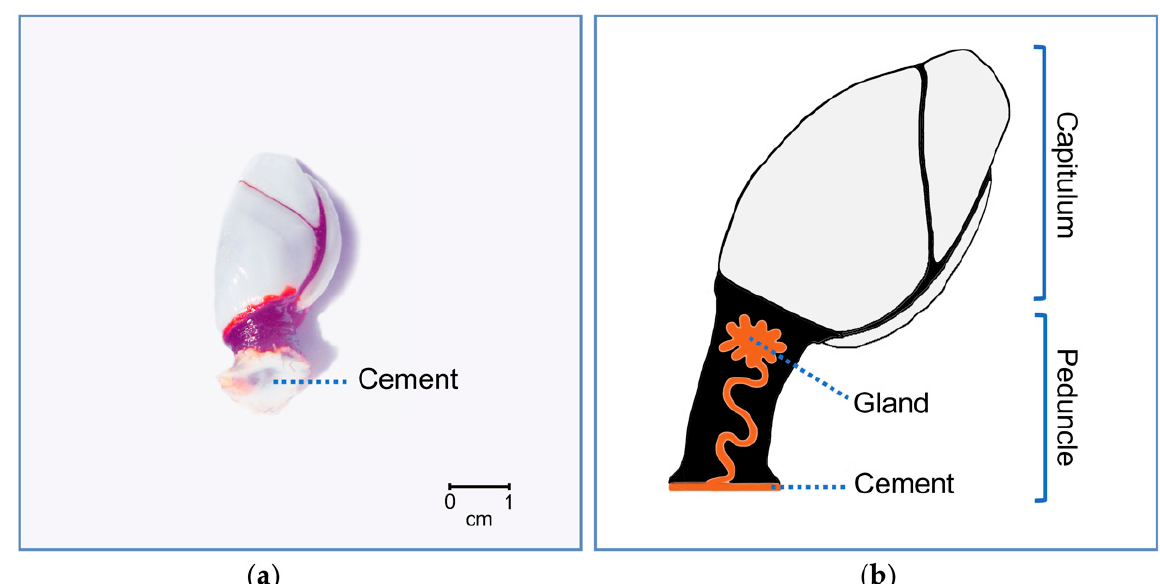
Figure 1. The pelagic gooseneck barnacle Lepas anatifera ( a ) detached from the substrate, showing the cement at the base of the peduncle; ( b ) schematic drawing showing a section of the peduncle, highlighting the cement apparatus, formed by clusters of adhesive-secreting cells that together constitute the gland, located in the upper central core, embedded in an apical layer of connective tissue, just beneath the capitulum. Gland secretion passes through a network of ducts that carry the adhesive to the base of the peduncle forming the cement.